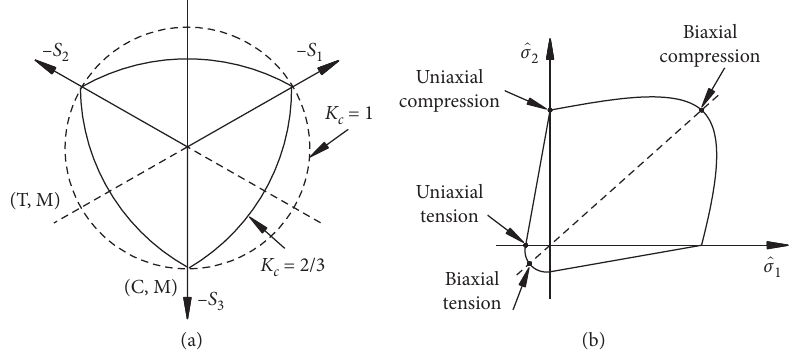
Figure 15: Illustration of concrete damage plasticity model: (a) deviatoric plane; (b) plane stress yield surface.